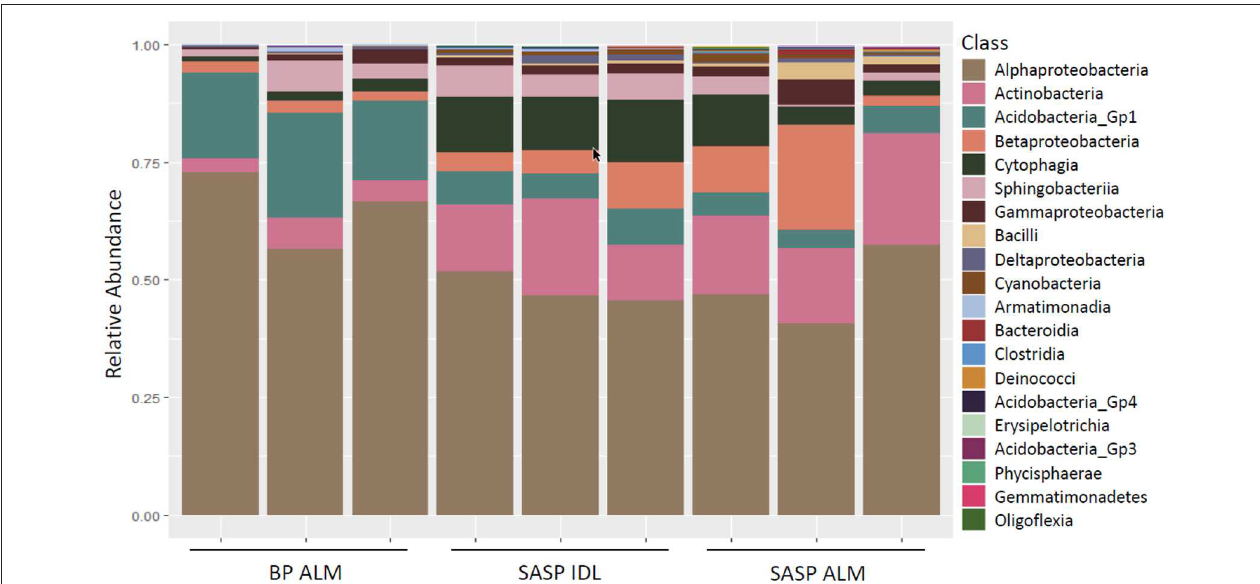
FIGURE 12 | Relative abundance of microorganism in each replicate at the class level for samples from Berthoud Pass (BP, all layers merged, ALM), and Swamp Angel Study Plot (SASP, individual deposited layers, IDL and all layers merged, ALM).